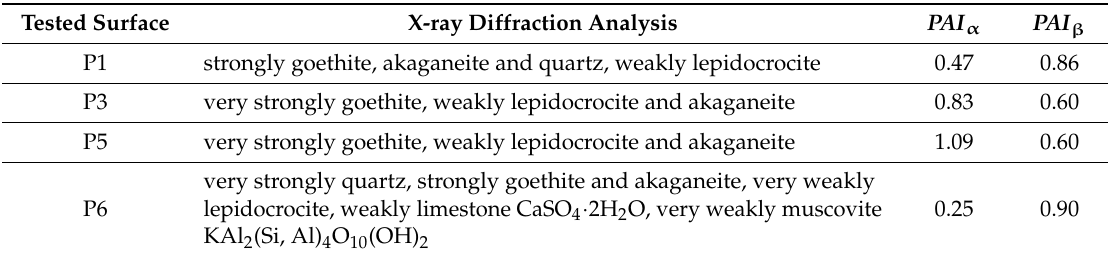
Table 4. X-ray diffraction analysis—samples withdrawn from structures of bridge No. 1.